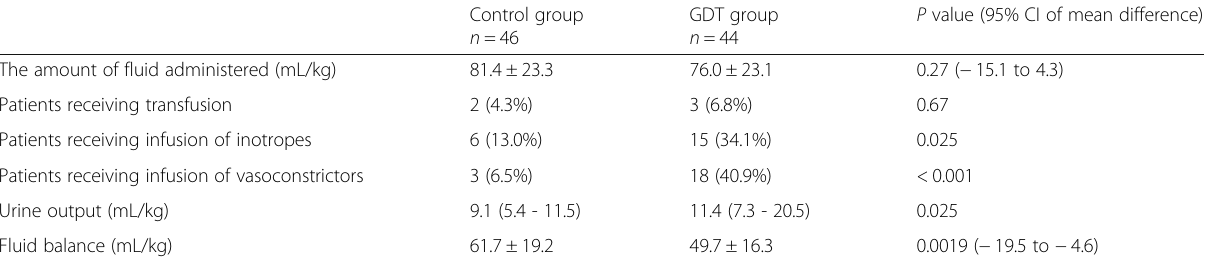
Table 2 Summary of hemodynamic management, urine output, and fluid balance